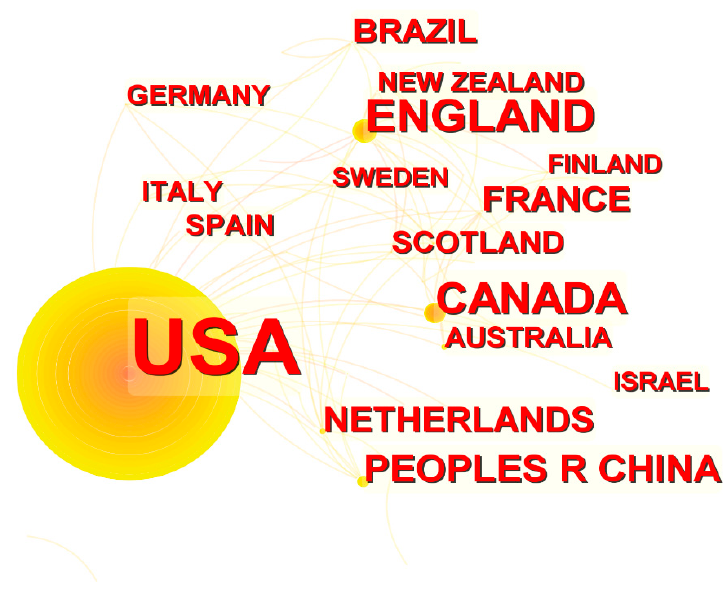
Figure 4. A network map showing national collaborations in RSH research.